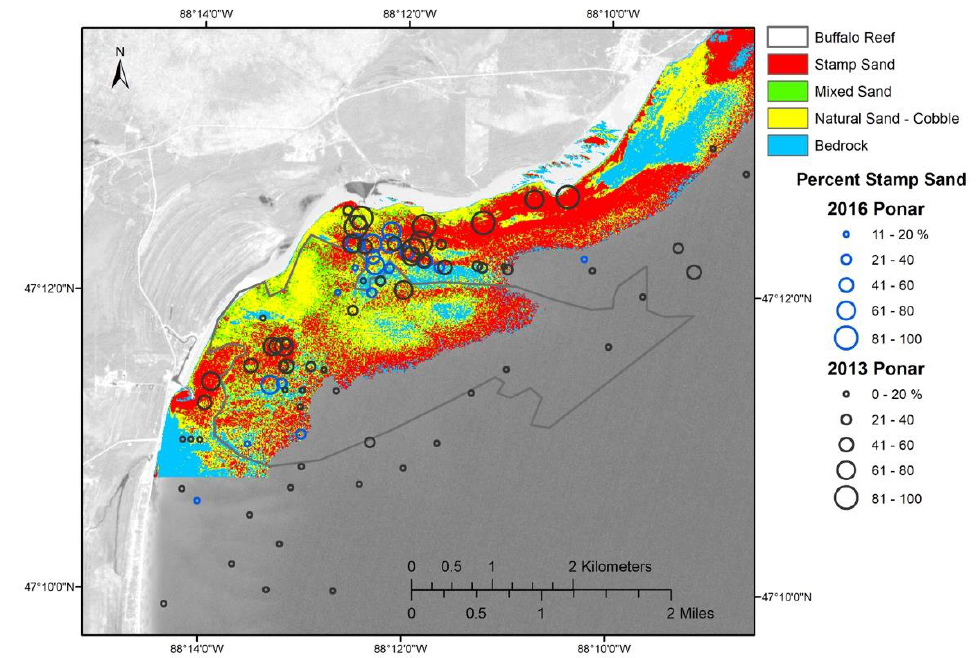
Figure 16. Comparison of observed stamp sand percentage from Ponar collections (2012–2017) with Sentinel-2 bottom type classification (19 May 2016). The Sentinel-2 image was depth-corrected using a modified Lyzenga Method on Band 3 (Lyzenga et al. 2006). Notice how the Lyzenga method appears to indicate high variable stamp sand concentrations ringing all deep margins, whereas Ponar observations indicate relatively low concentrations.